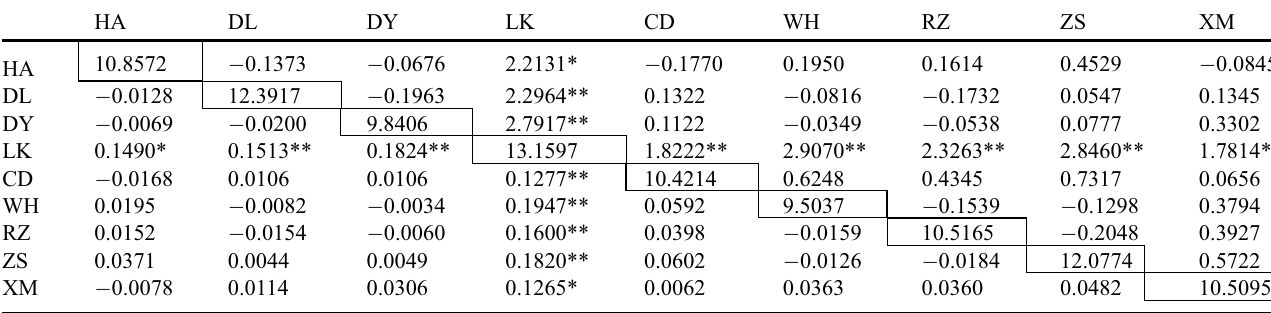
Table 3. Corrected average pairwise differences (above diagonal) and F ST values (below diagonal) between populations and average number of pairwise differences on the diagonal within population.